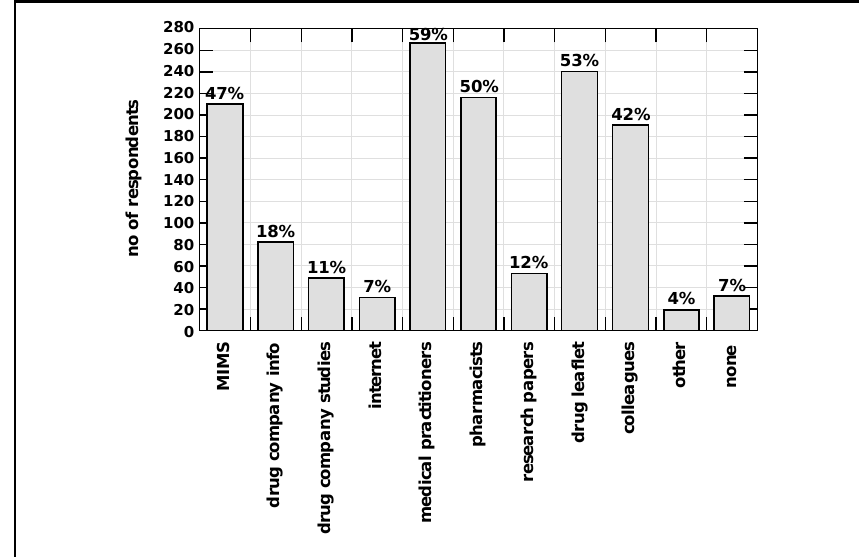
Figure 3: Sources of drug information consulted by respondents in the six months prior to completion of the